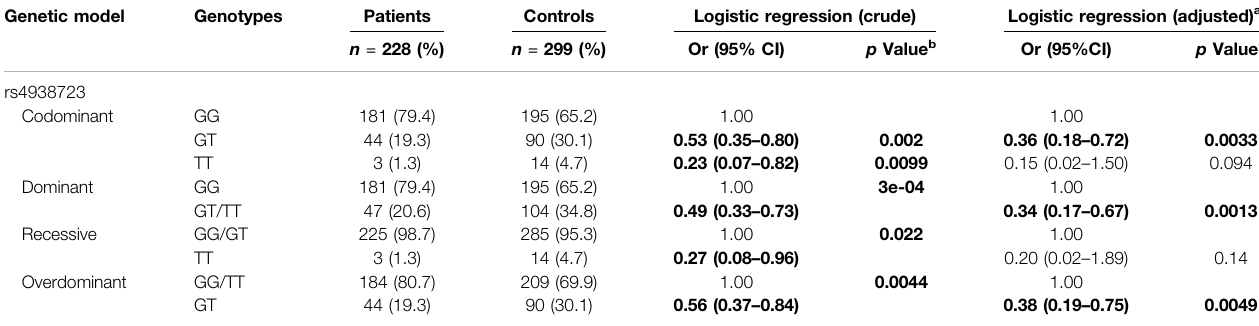
TABLE 1 | Association between the rs4971066 and risk of gastric cancer Genetic model Genotypes Patients Controls Logistic regression (crude) Logistic regression (adjusted) a